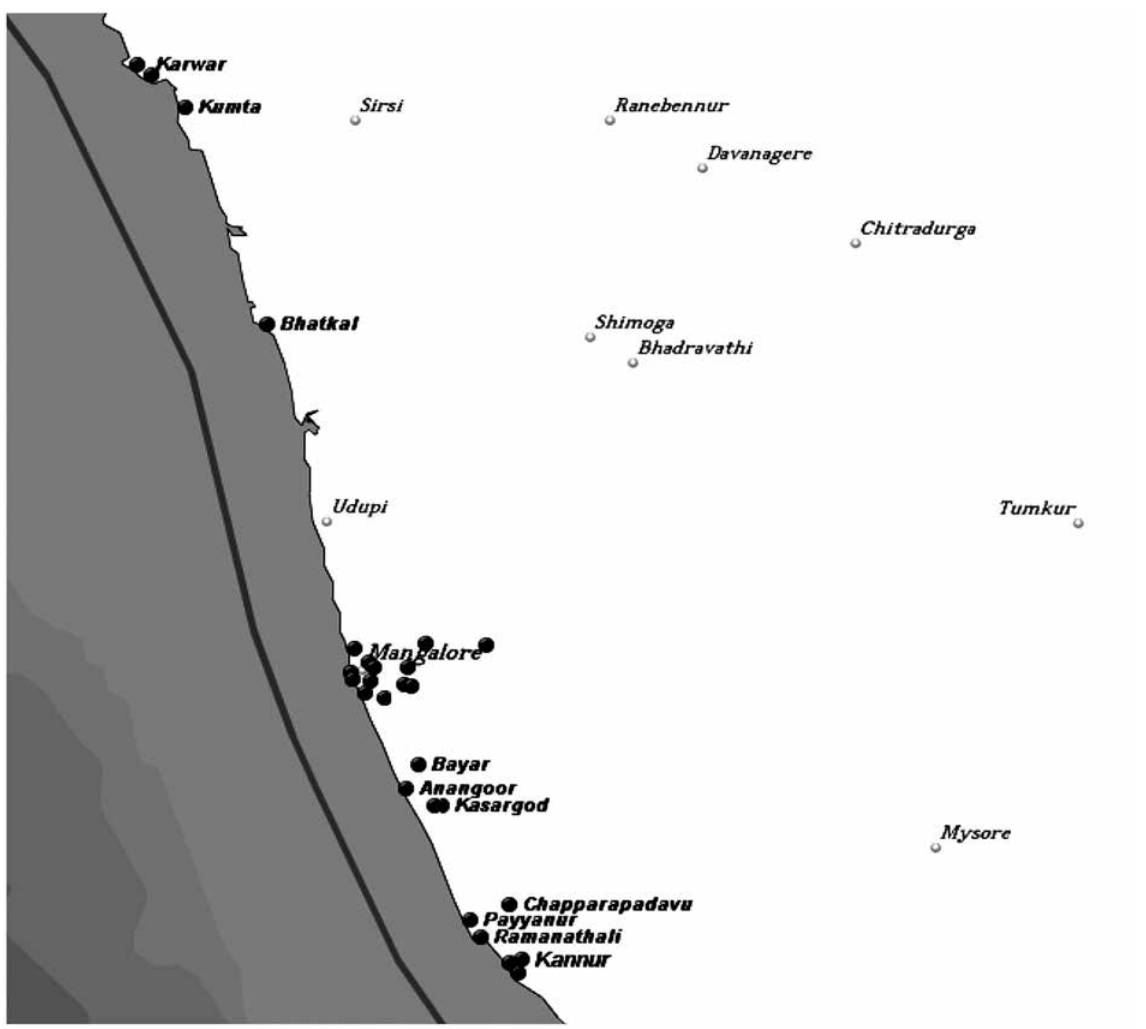
Figure 1: Geographical distribution of 28 melioidosis